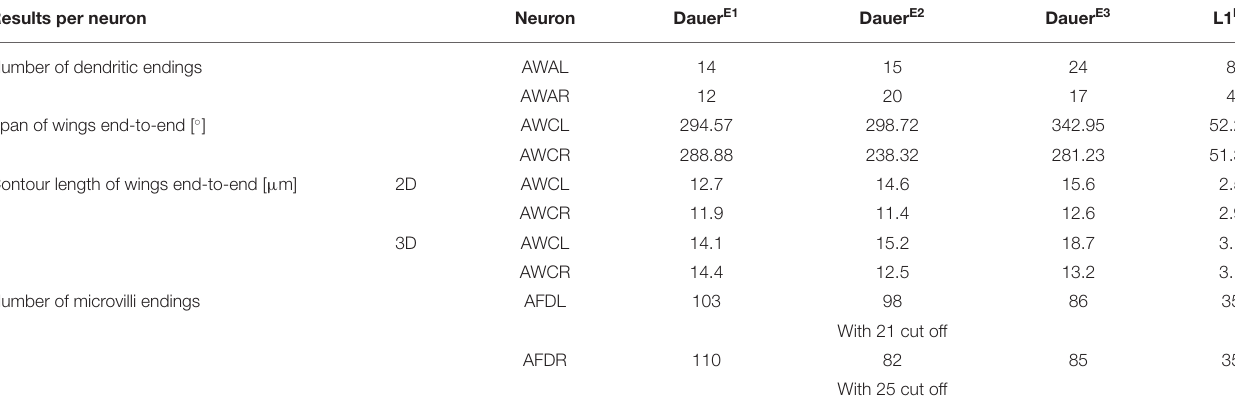
TABLE 1 | Measurements of amphid neuron endings. Results per neuron